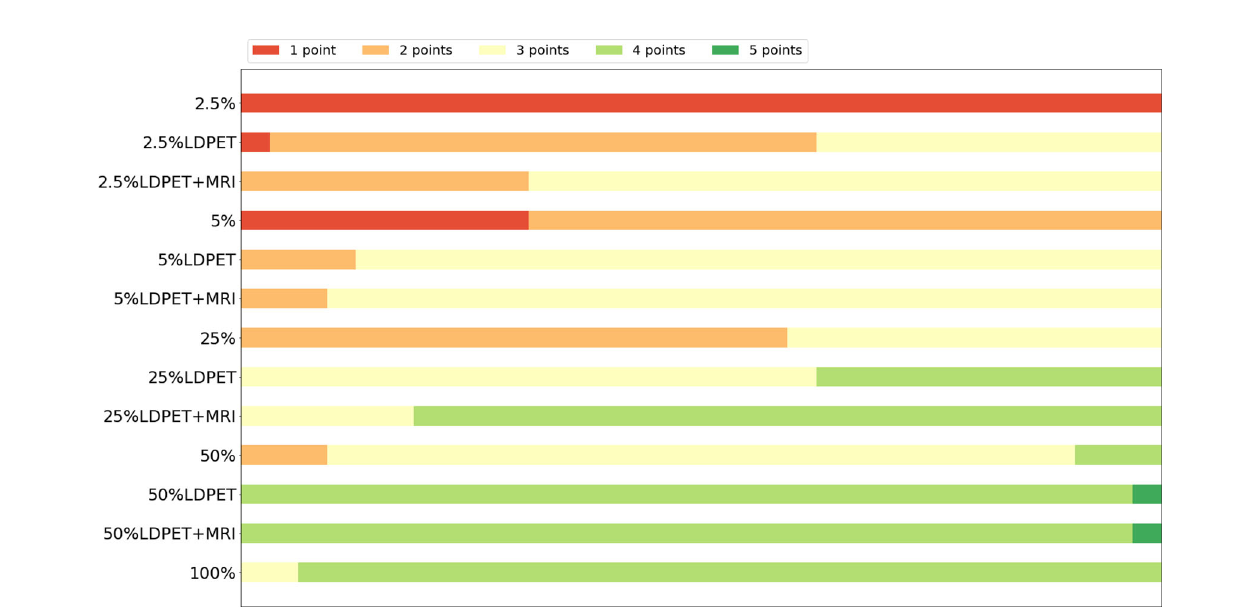
FIGURE 6 | Distribution of clinical quantitative scores from nuclear medicine doctors on LDPET images, synthesized FDPET images, MR prior-synthesized FDPET images, and target